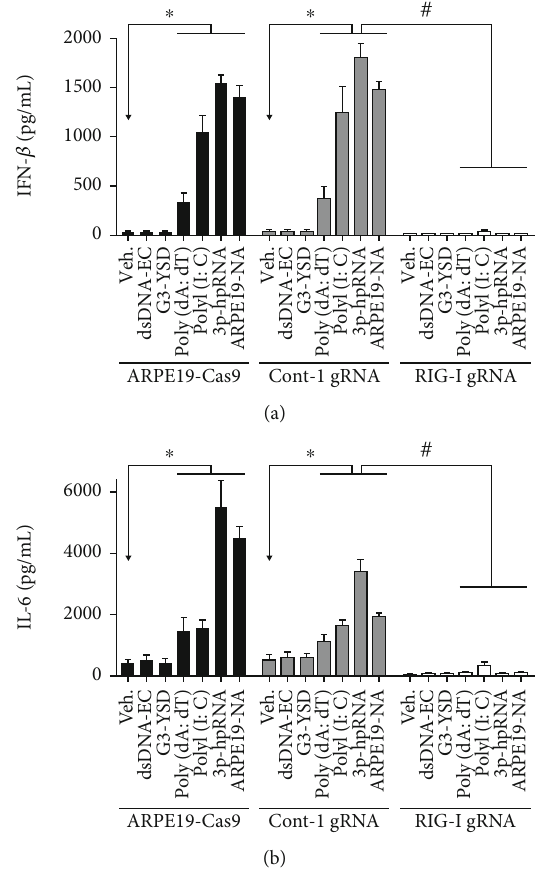
Figure 3: ARPE-19 cannot sense nucleic acids in RIG-I-de fi cient cells. The ARPE-19 RIG-I KO cell line was generated and validated using an ARPE-19-Cas9 line (see Supplementary Figure 3). Cells were stimulated with indicated inducers at 0.25 μ g/mL, and the release of IFN- β or IL-6 was measured by ELISA 24 h after stimulation. (a) The IFN response was abolished in RIG-I KO ARPE-19 cells. Similar to ARPE-19, Cas9-expressing ARPE-19 cells respond to RNA but not DNA. Interestingly, ARPE-19 RIG-I KO cells did not respond to any tested